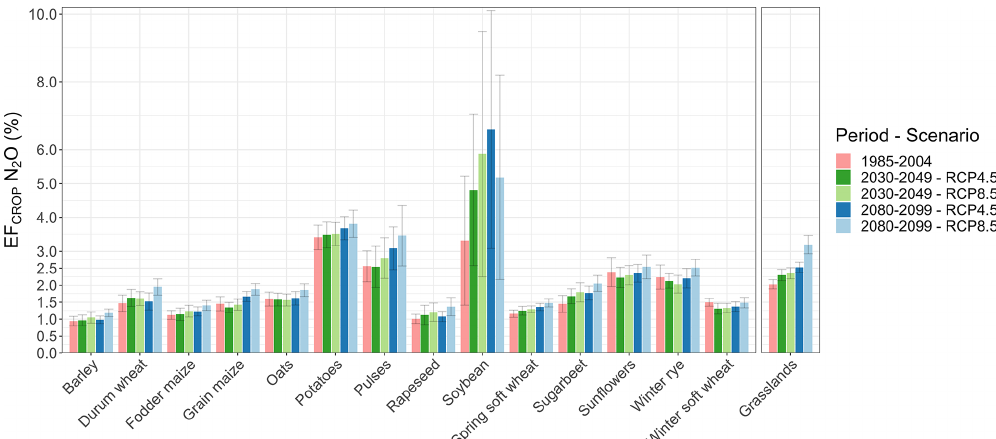
Figure 7. The emission factor (EF) for N 2 O (%) for the different crops and grasslands for the historical period (1985–2004), towards the mid-century (2030–2049) and towards the end of the century (2080–2099), for the two climatic scenarios RCP4.5 and RCP8.5. The EF is the ratio between the N emitted as N 2 O from crops and grasslands and the N applied as fertiliser.